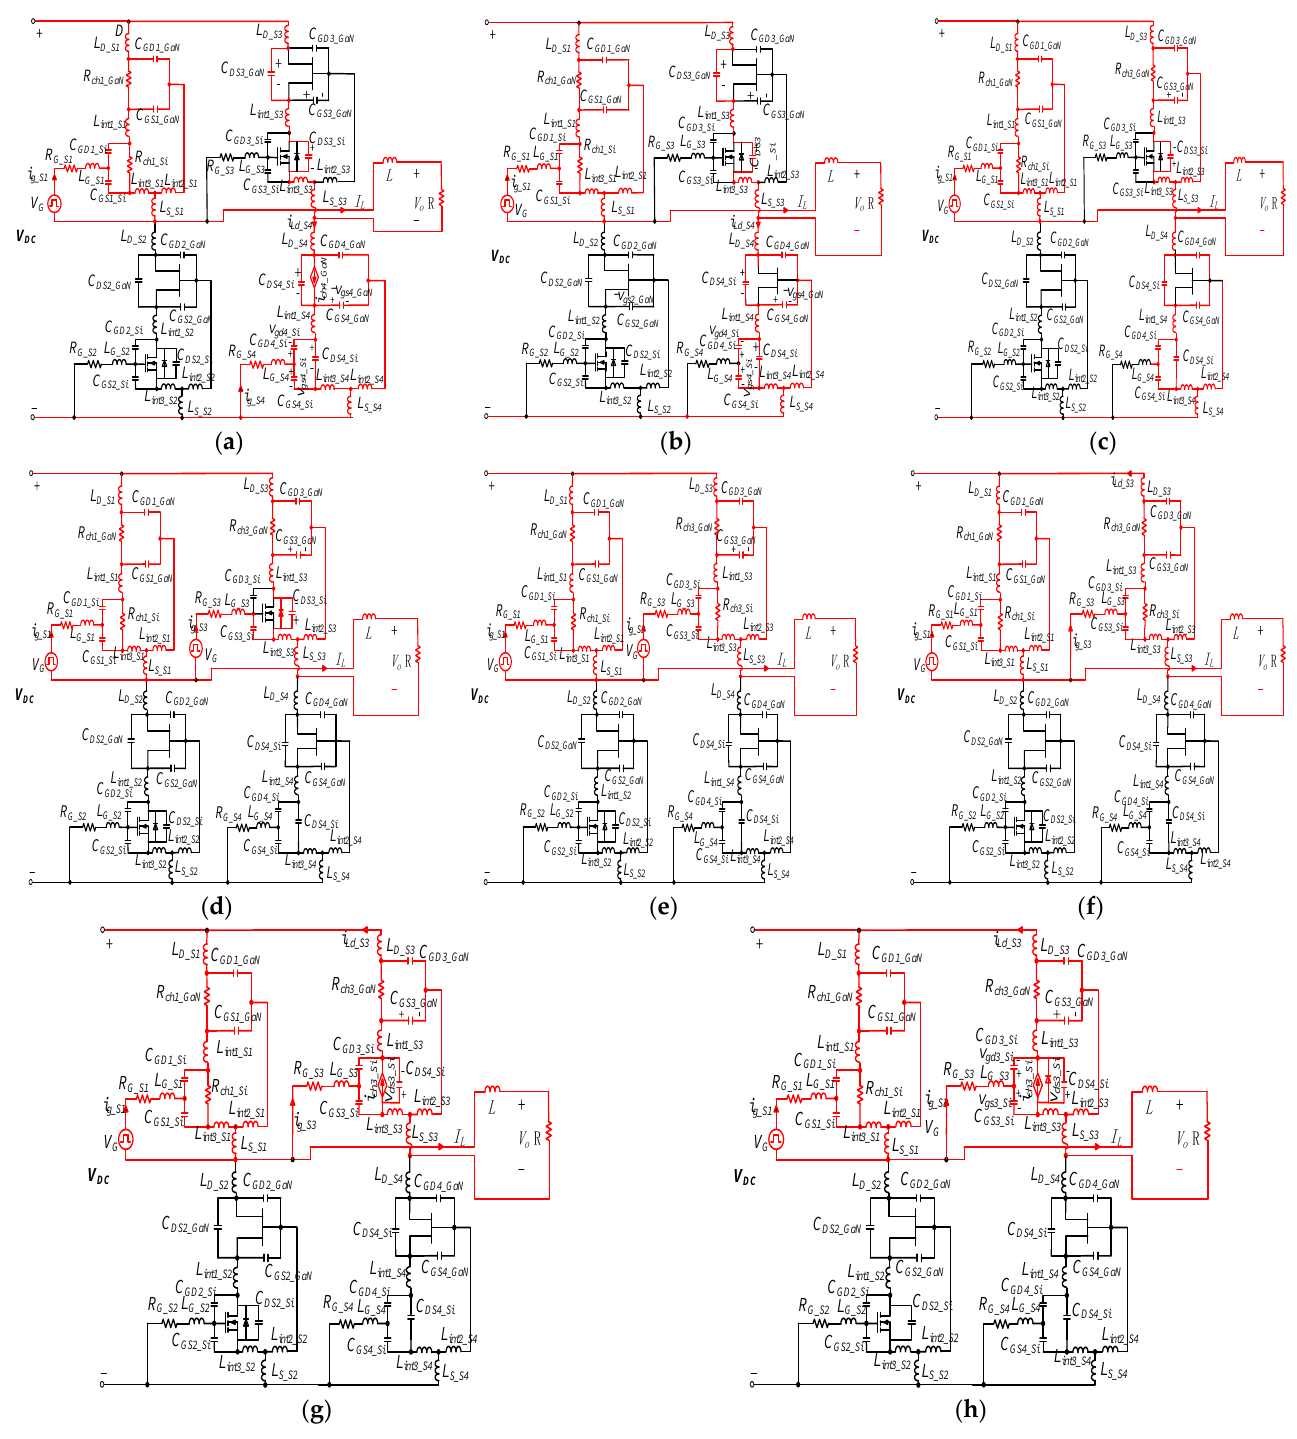
Figure 4. The equivalent circuit of positive tun-off, reverse turn-on, and reverse turn-off stage. ( a ) Positive turn-off III; ( b ) Positive turn-off IV; ( c ) Reverse turn-on state I; ( d ) Reverse turn-on state II; ( e ) Positive turn-on VI; ( f ) Reverse turn-off state I; ( g ) Reverse turn-off state II; ( h ) Reverse turn-off state III. Stage IV: The drain-source voltage of the S 4 rising